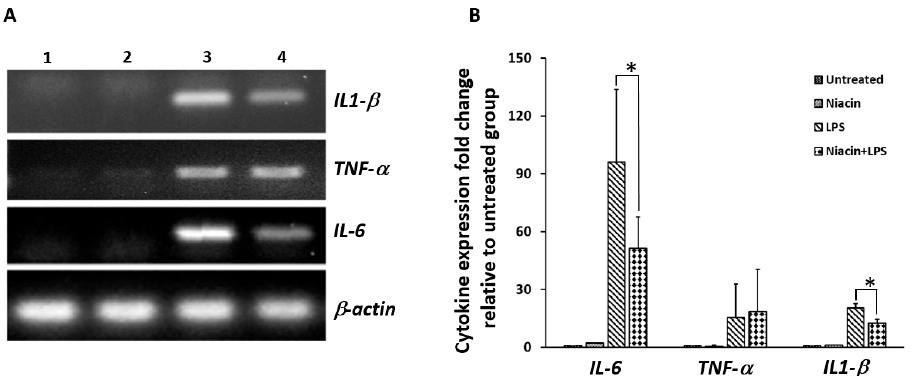
Figure 3. Effect of niacin on the expression of IL-6, TNF- α and IL-1 β mRNA induced by LPS in RAW264.7 macrophage cell line by PCR analysis. ( A ) Expression of IL-6, TNF- α and IL-1 β transcripts induced by LPS in the RAW264.7 macrophage cell line. Untreated cells (lane 1), treated with 0.4 mM niacin (lane 2), LPS (lane 3) nd LPS in the presence of niacin (lane 4). β -actin was used as an internal control. ( B ) Densitometric analysis showing the fold changes in expression of IL-6, TNF- α and IL-1 β transcripts after normalization with β -actin. Data presented is Mean ± SD ( n = 3). * p < 0.05.